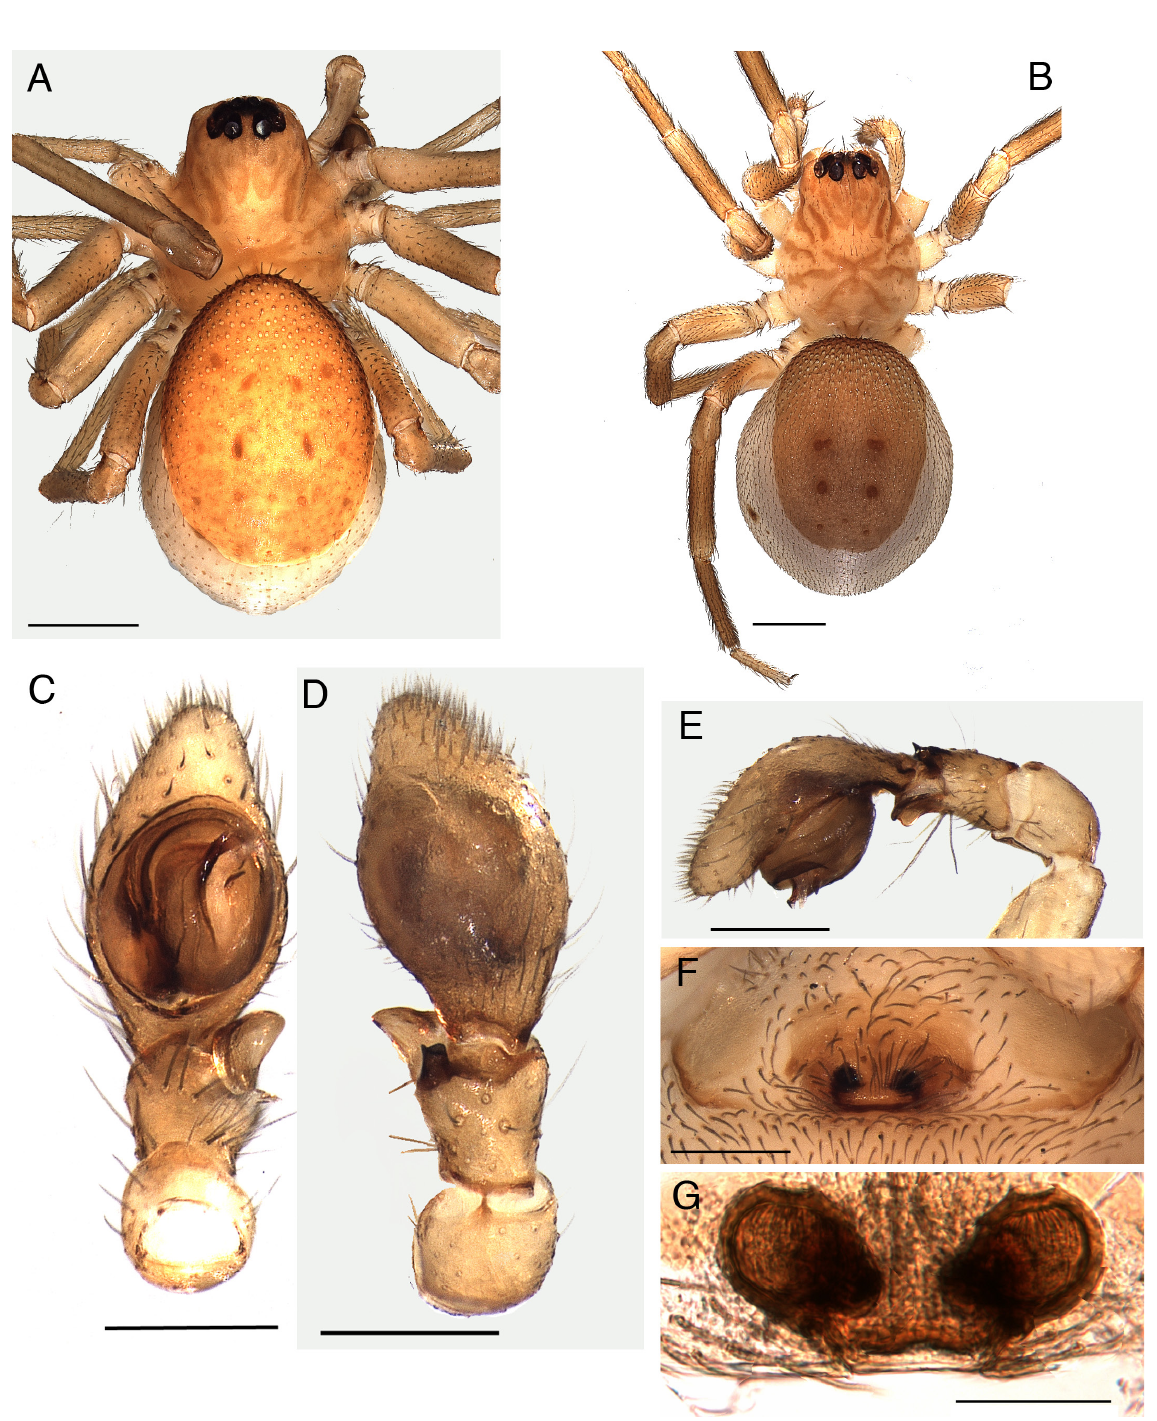
Fig. 9. Chumma subridens sp. nov. A, C–E . Holotype, ♂. B, F–G . Paratype, ♀ (NCA 2013/4474). A . Habitus, dorsal view. B . Habitus, dorsal view. C . Palp, ventral view. D . As preceding, dorsal view. E . As preceding, retrolateral view. F . Epigyne, ventral view. G . Epigyne, cleared, dorsal view. Scale bars: A–B = 0.5 mm; C–G = 0.2